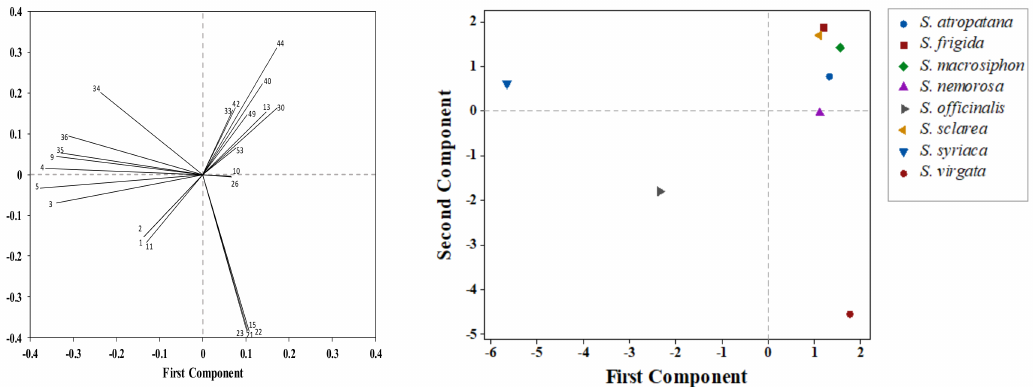
Figure 5. Biplot based on the first two principal components of chemical composition data, demon- strating the relationship among compounds identified in the essential oils ( Left ) and its ratios in studied species ( Right